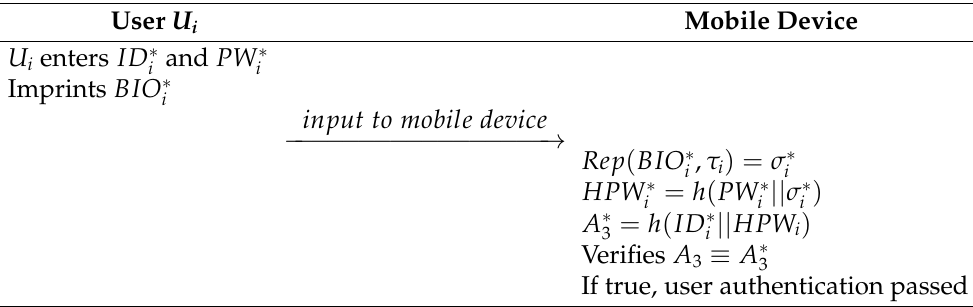
Figure 2. Login phase of Chen et al.’s